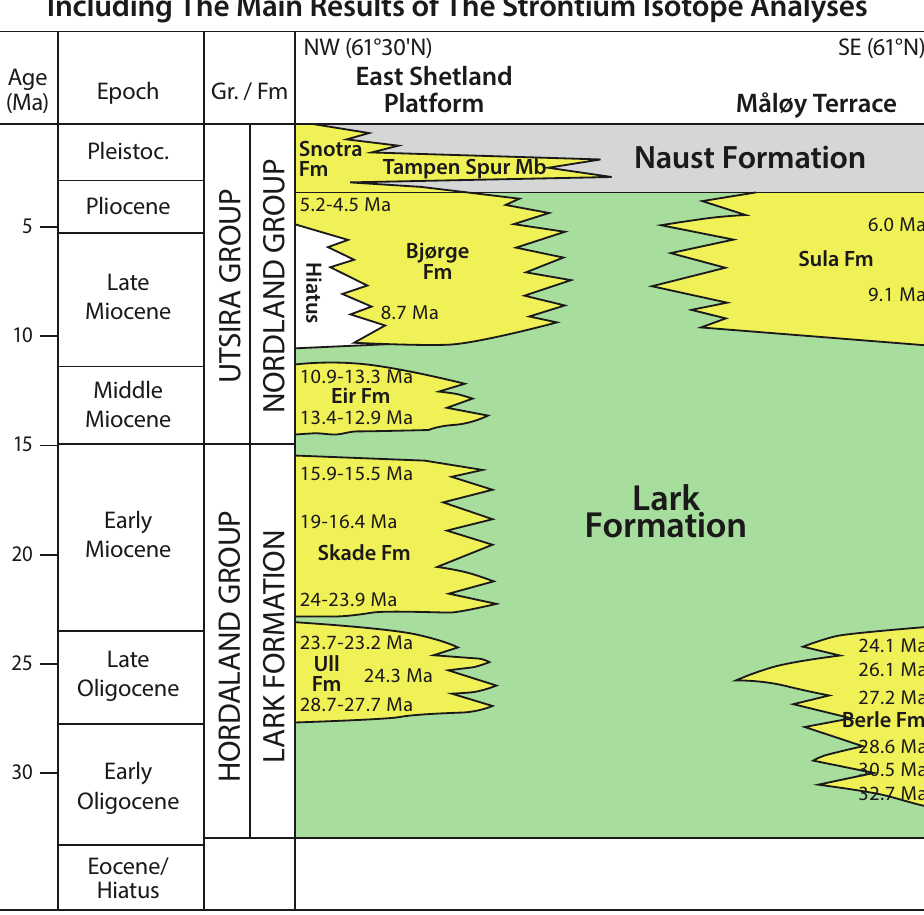
Figure 19. Post-Eocene lithostratigraphy of the Norwegian North Sea at approximately 61°N–61°30´N including the main ages from strontium analyses based on fossil tests interpreted to be in situ (modified after Eidvin et al.,